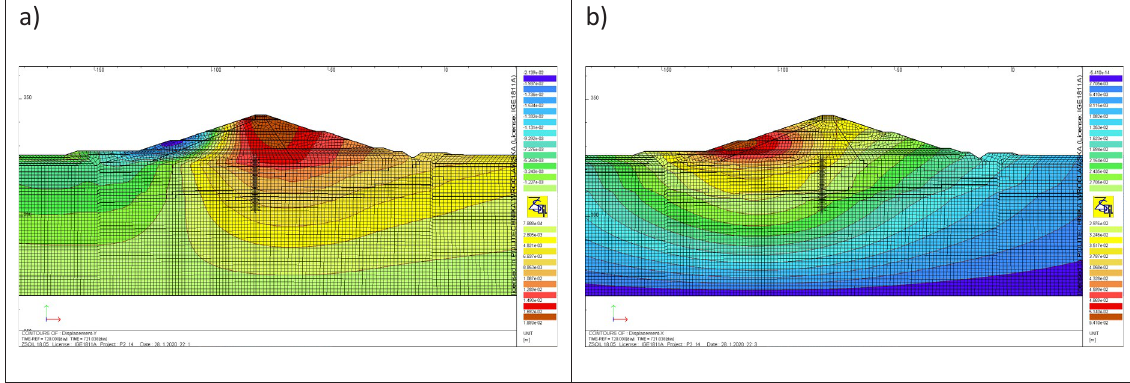
Fig. 16. An exemplary map of displacement s : a) vertical; b) horizontal